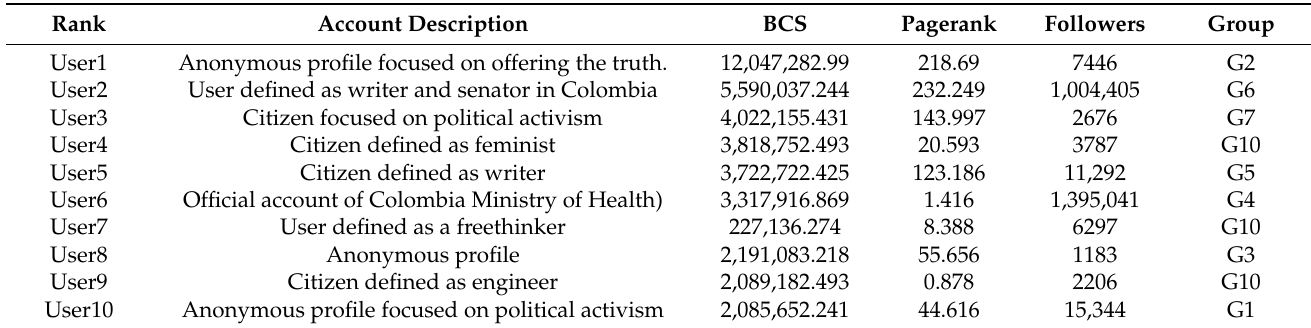
Table 2. Influential users ranked according to their betweenness centrality score